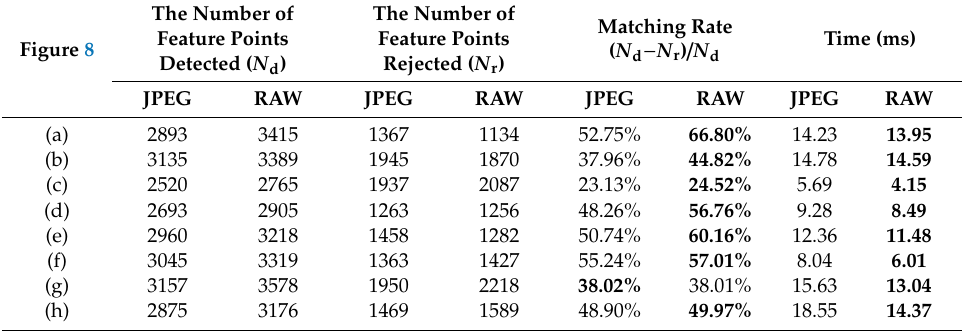
Table 3. The comparative analysis of feature-matching time and matching rate.